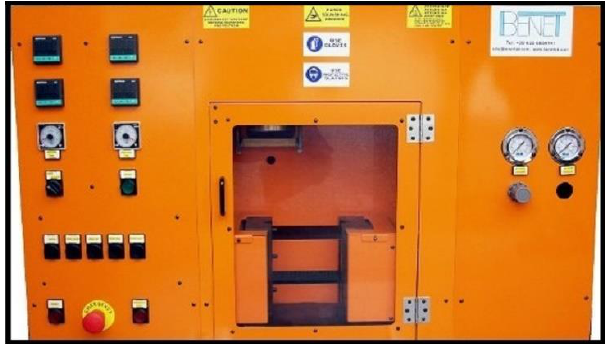
Figure 3. Benetlab laboratory core blower.